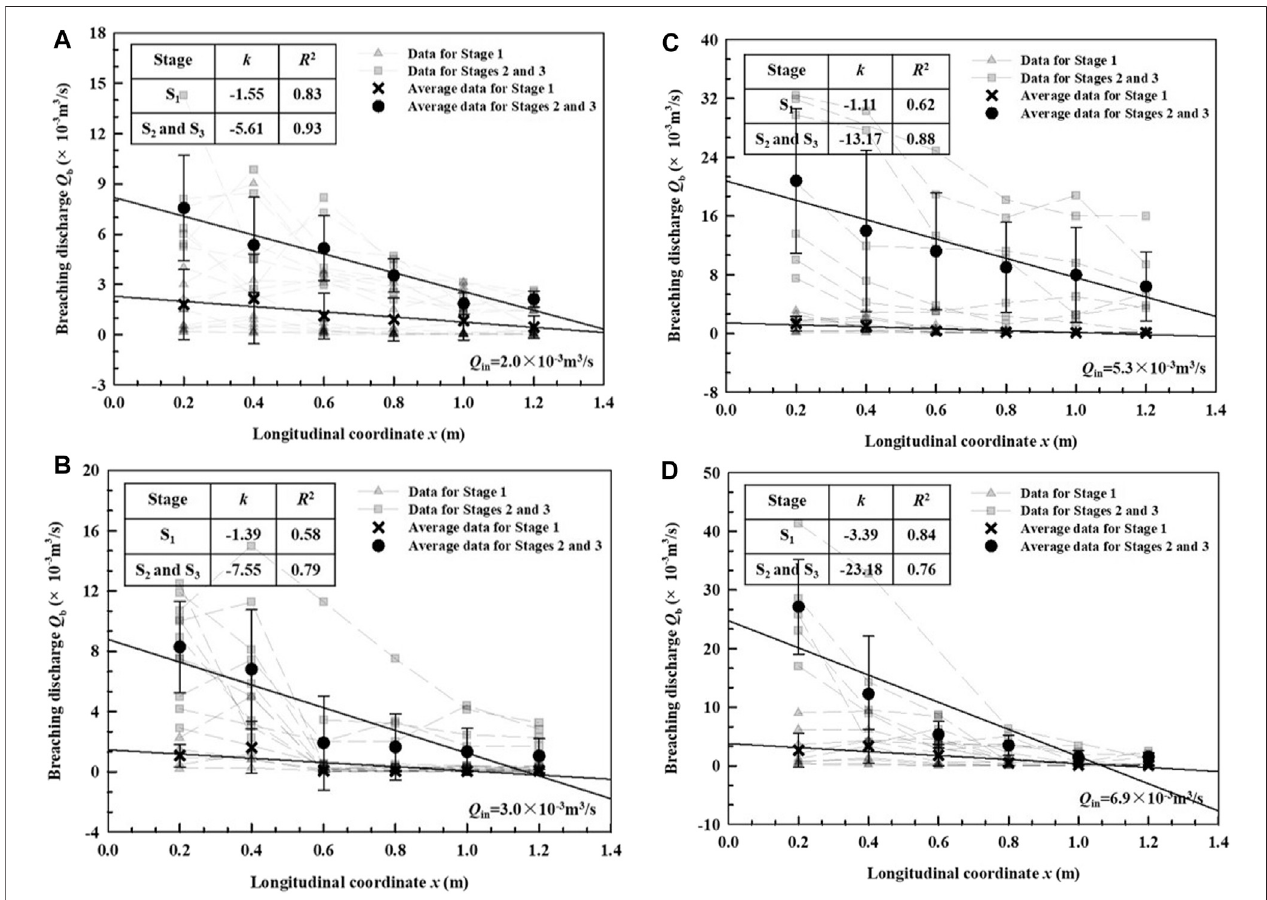
FIGURE8| Theevolutionofaveragebreaching fl owdischargealongthelongitudinaldirectionduringdifferentStage1andStages2and3 (A) Q in (cid:2) 2.0 × 10 − 3 m 3 /s (B) Q in (cid:2) 3.0 × 10 − 3 m 3 /s (C) Q in (cid:2) 5.3 × 10 − 3 m 3 /s (D) Q in (cid:2) 6.9 × 10 − 3 m 3 /s.